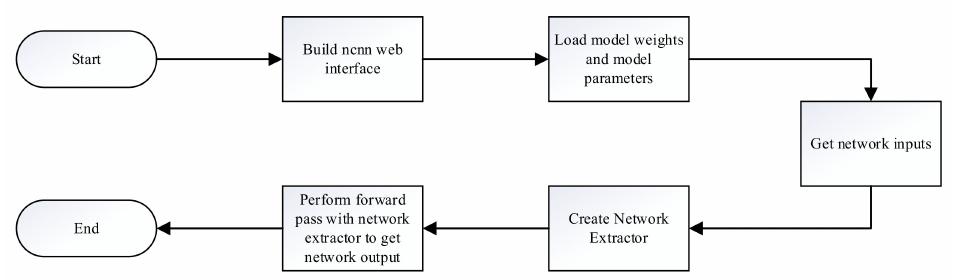
Figure 6. The NCNN framework for building networks and the inference process.